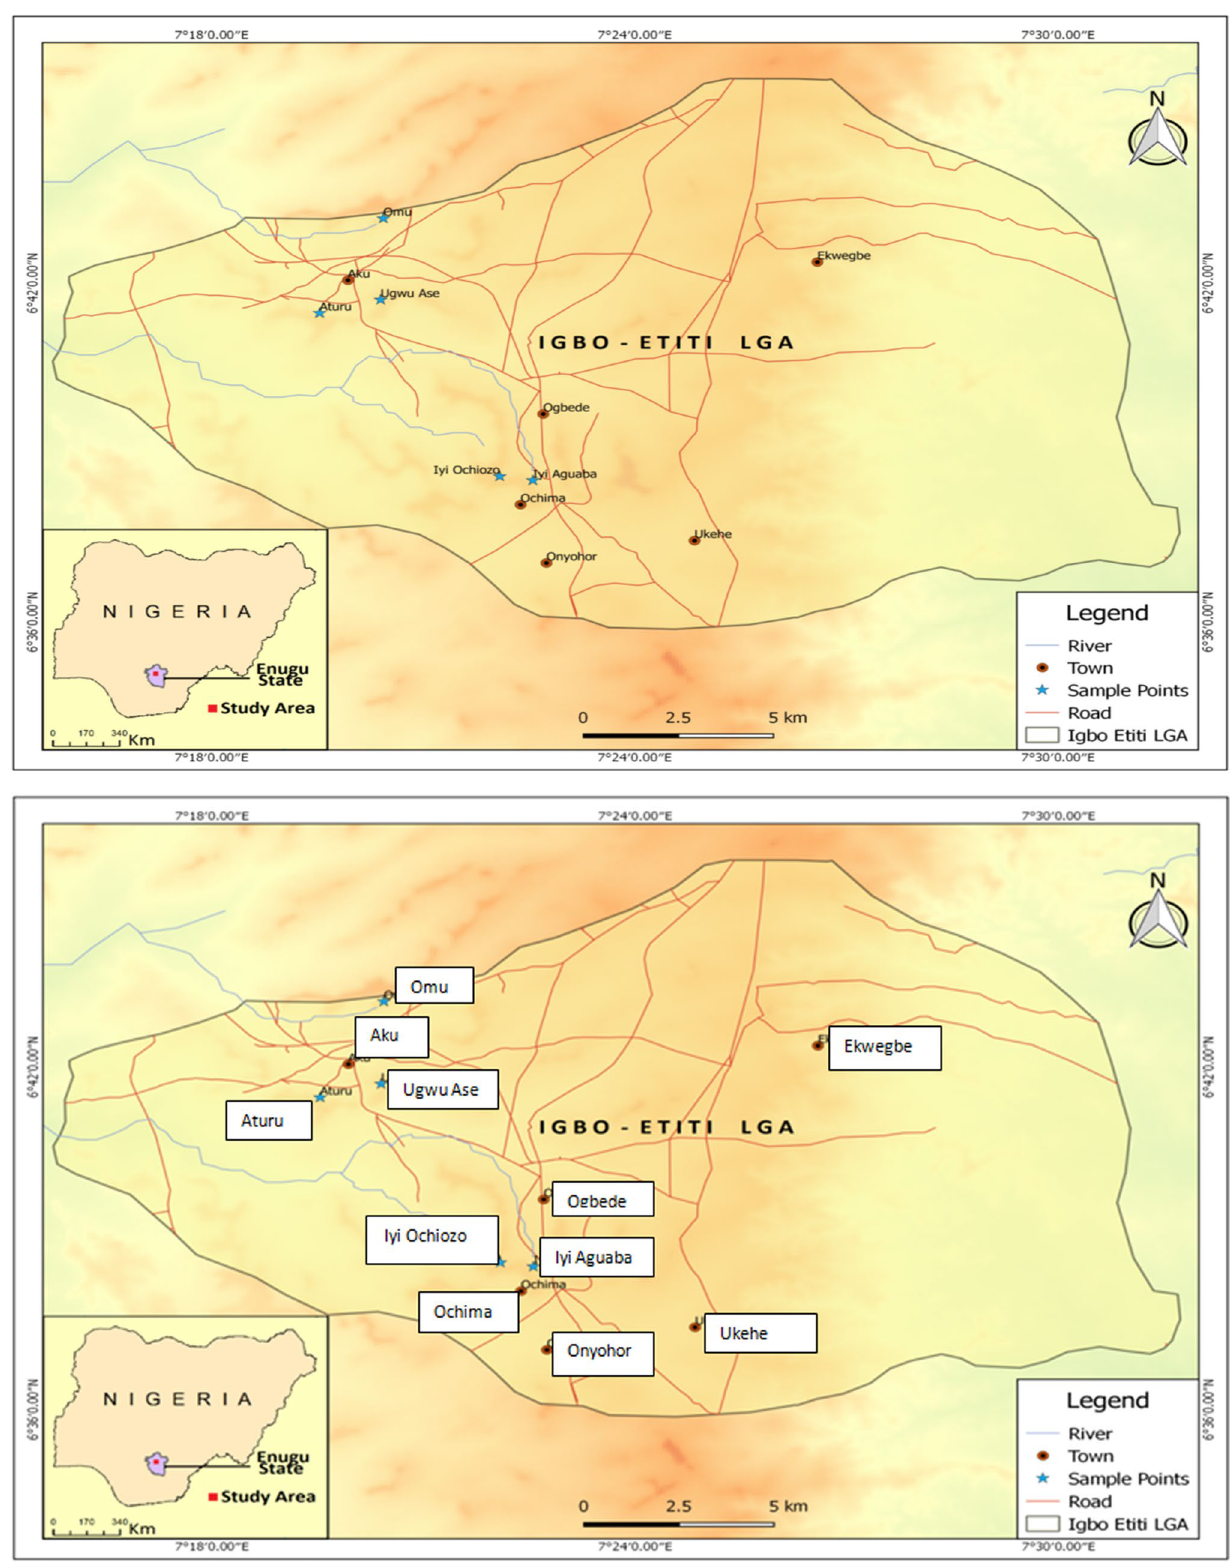
Fig. 1 Map of Igbo-Etiti LGA showing the Sampling